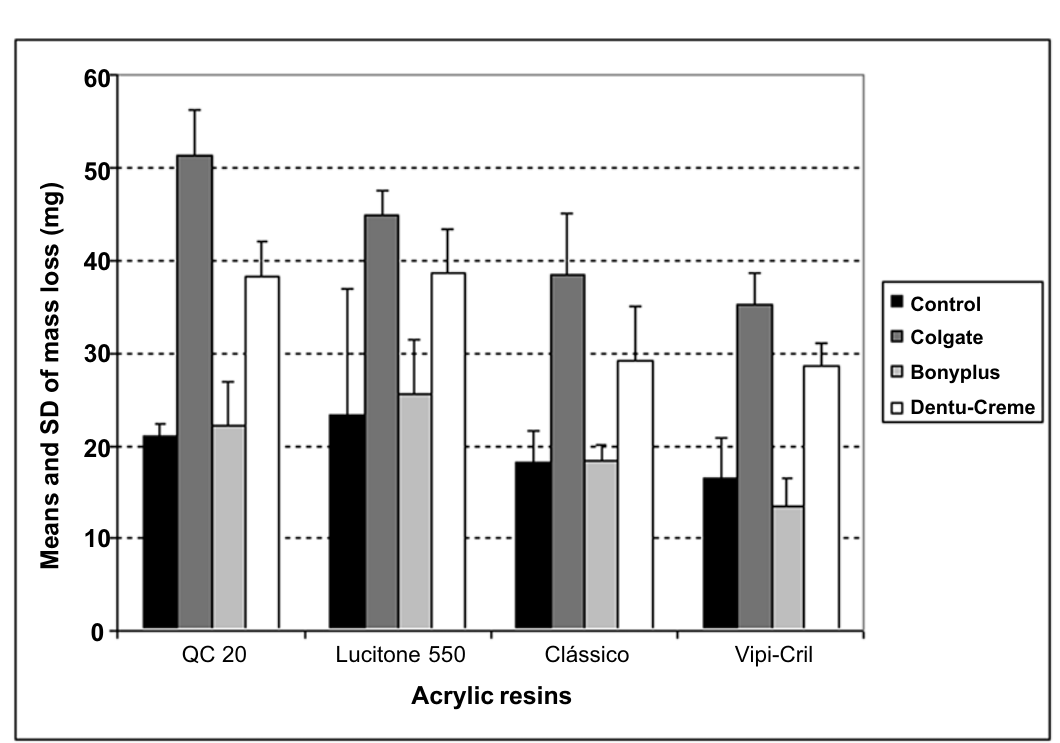
FIGURE 1- Means and SD of mass loss (mg) of the tested acrylic resin after dentifrice